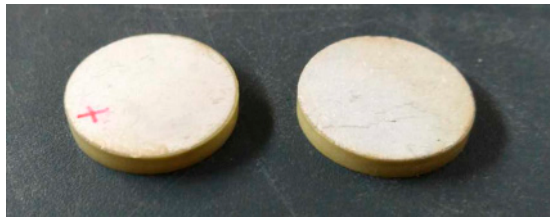
Figure 4. The positive and negative electrode surface of PZT-5 piezoelectric ceramic patches.